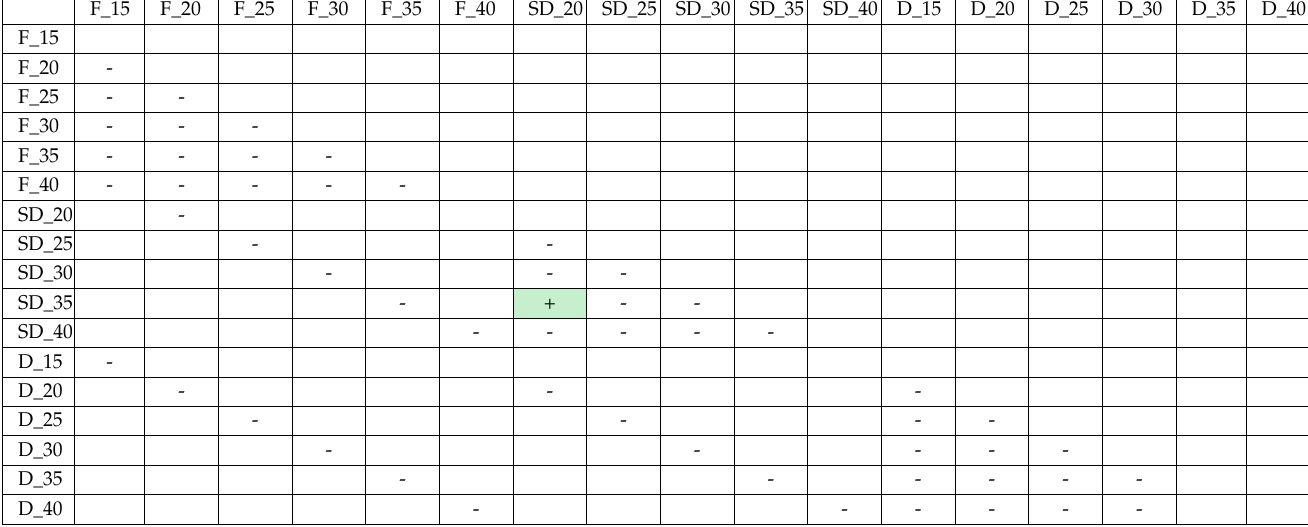
Table A3. WHC (volume based) significance − 5 kPa, plus (+) and green background indicates significant differences, minus (-) indicates statistically insignificant differences.